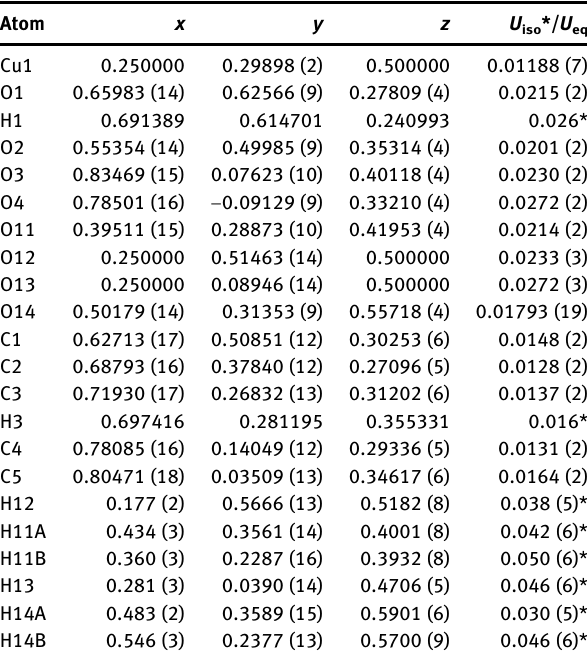
Table  : Fractional atomic coordinates and isotropic or equivalent isotropic displacement parameters (Å 